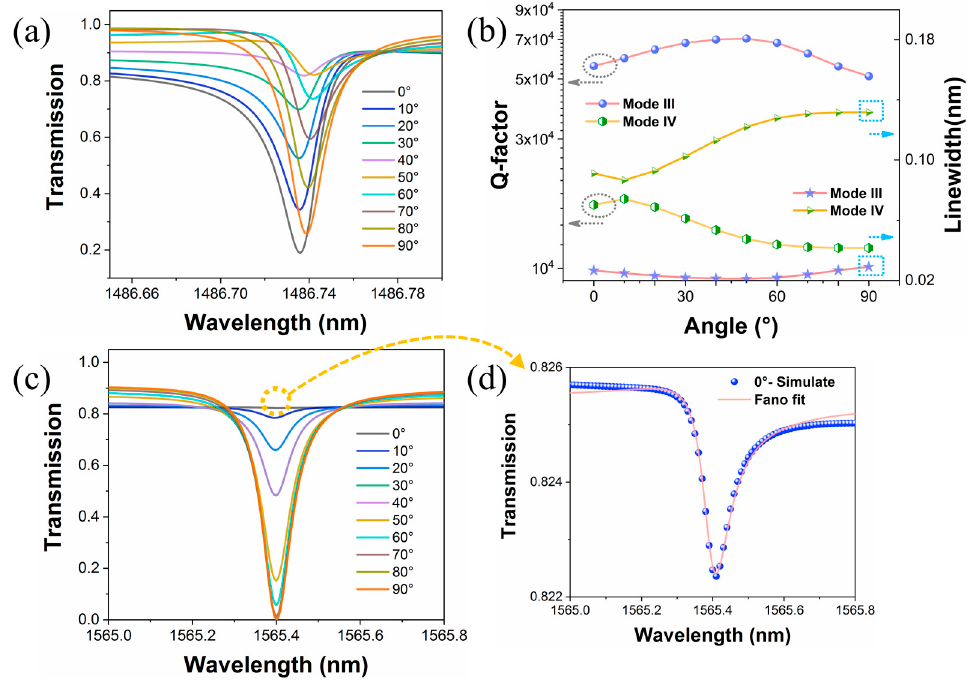
Figure 8. The calculated transmission curves with varying polarization angles from 0° to 90° for mode III ( a ) and mode IV ( c ). ( b ) The Q factors and linewidths for mode III and mode IV at different polarization angles. ( d ) The enlarged transmission curve for mode IV at resonant wavelength and Fano fit curve.